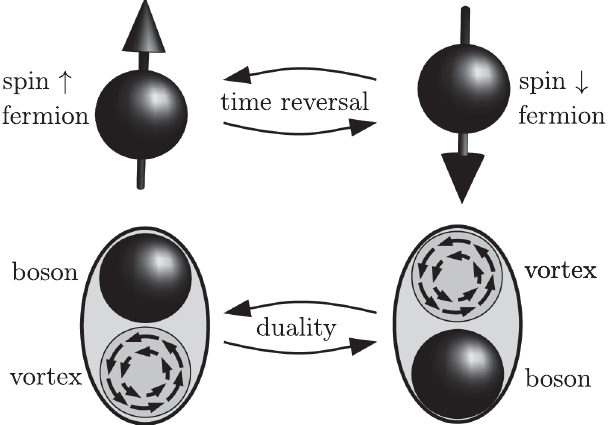
FIG. 1. In our formulation, the fermion spin is interpreted as the relative orientation of the boson and vortex. Under fermionic time reversal, the spin is flipped, corresponding to replacing bosons ↔ vortices, i.e., duality. This schematic picture will be made precise in the course of this